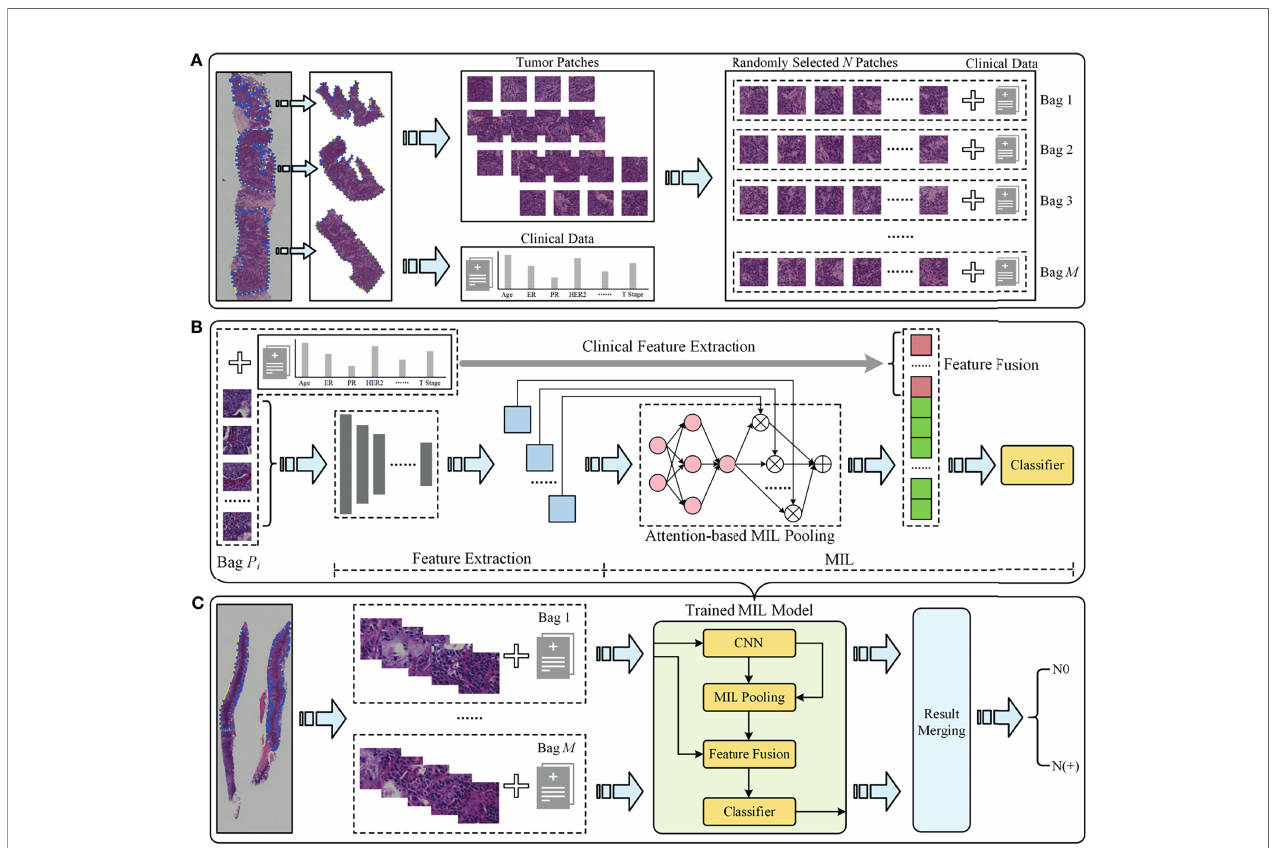
FIGURE 2 | The overall pipeline of the deep learning core-needle biopsy incorporating the clinical data (DL-CNB+C) model to predict axillary lymph node (ALN) status between N0 and N(+). (A) Multiple training bags were built based on clinical data and the cropped patches from the selected tumor regions of each core- needle biopsy (CNB) whole-slide image (WSI). (B) DL-CNB+C model training process included two phases of feature extraction and multiple-instance learning (MIL), and fi nally the weighted features fused with clinical features were used to predict classi fi cation probabilities and calculate the cross-entropy loss. (C) The predicted probabilities of each bag from a raw CNB WSI were merged to guide the fi nal ALN status classi fi cation between N0 and